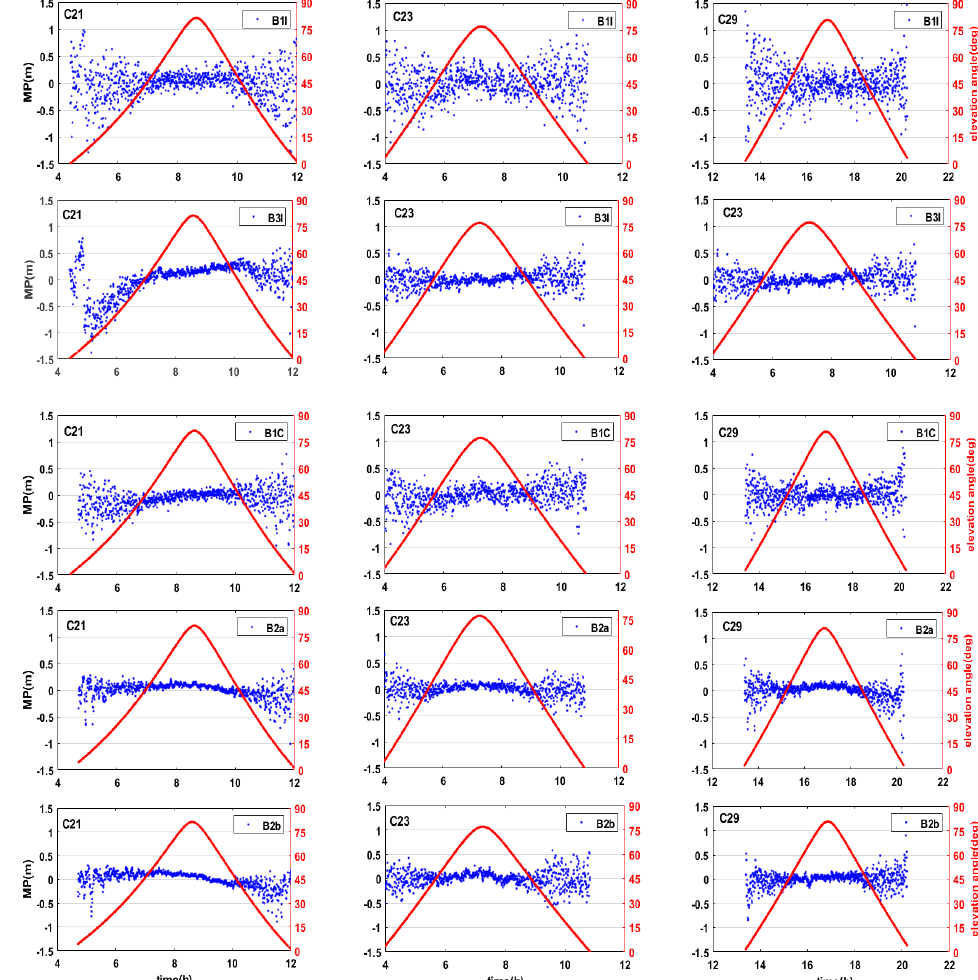
Figure 4. The MP series of BDS-3 MEO satellites in different frequencies.